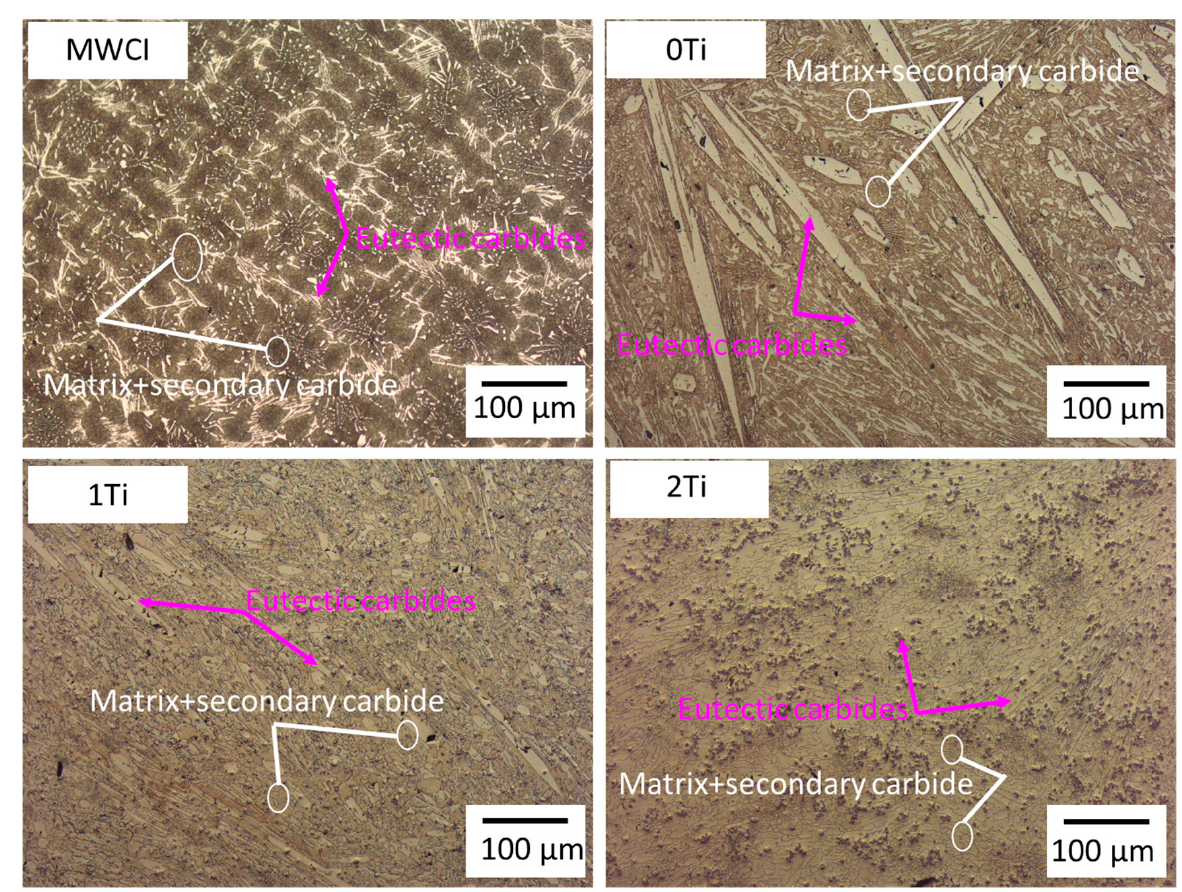
Figure 4. The microstructure of the materials after being etched in hydrochloric liquid.